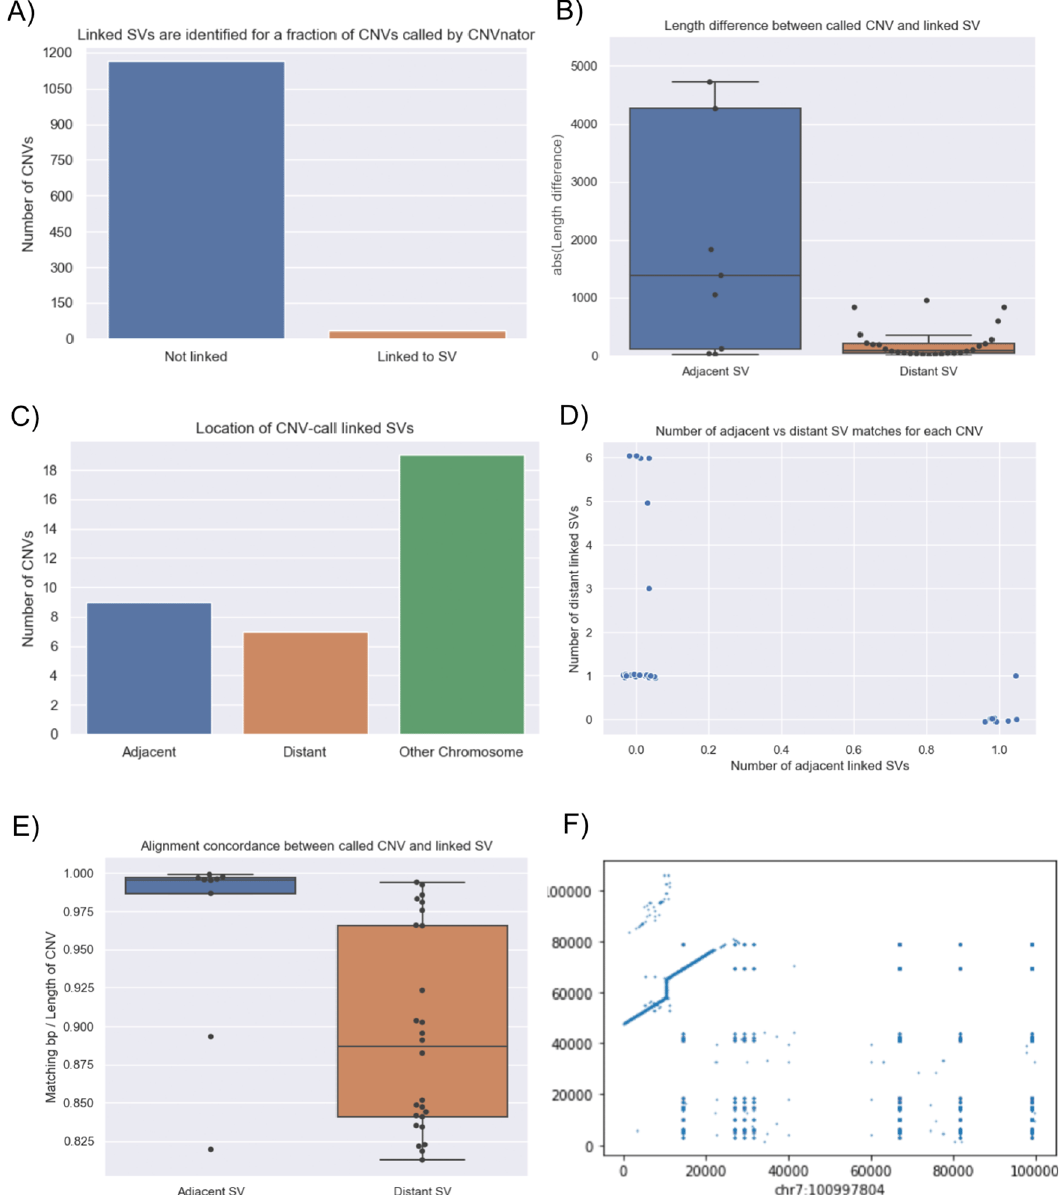
Figure 12. Summary the linkage statistics showing the characteristics of disparities between the CNV calls and SVs. In terms of linkage statistics, the majority of the CNVs identified have not been linked to a SV event, as indicated by A . One of the main reasons for the unsuccessful linking is the length disparity between the called CNV events and SV events as shown in B . Overall, among linked CNV and SV events, the distribution of three major categories are shown in C : adjacent events, distant events, and events spanning multiple chromosomes. Distant events are called in the case when the linked SV is at least 1Kbp away from the CNV call (either upstream or downstream). Details of the distribution of the adjacent and distant events per CNV call are given in D and E shows that alignment quality is better for adjacent matches when compared to more distant SV matches. While most links for a single CNV event are unanimously distant or adjacent, we observed an event in which a CNV was linked to both an adjacent and a distant SV which occurs on chromosome 7 ( F : adjacent: chr7:100997804 length 8325 and distant: chr7:100994092 length In order to release these filters/thresholds to the larger community for general usage, these filters need to be tailored specifically for specific assays. The optimal approach would be to focus on a particular use of SV calling (e.g. therapeutic oncology) with a particular assay of a certain average coverage and tumor purity. We suspect generating filters per SV